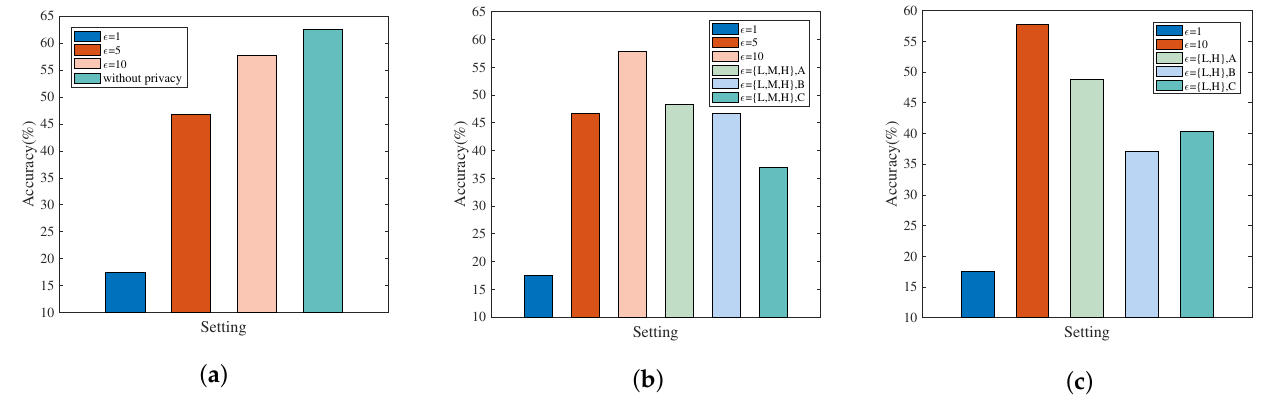
Figure 7. Simulation results on forest cover-types data. Clients’ training data are non-independent and identically distributed. ( a ) The non-personalized scenario. ( b ) The personalized scenario under the first privacy setting. ( c ) The personalized scenario under the second privacy set- ting. We nominate { 1,1,1,5,5,5,5,10,10,10 } as { L , M , H } (i.e., low, middle, high), and nominate { 1,1,1,1,1,10,10,10,10,10 } as { L , H } (i.e., low,